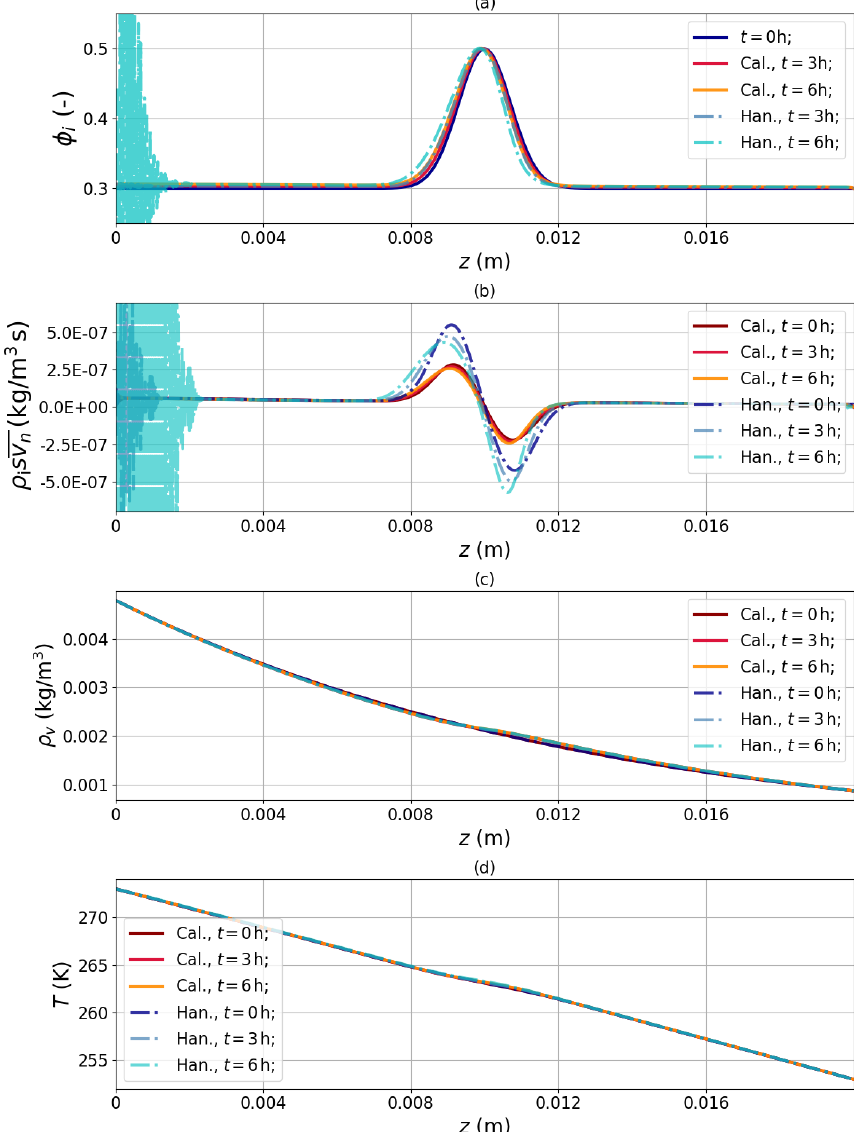
Figure 3. Comparison of Calonne’s and Hansen’s model each with their own formulation of coefficients. Both models are coupled to the evolving ice phase for an initial Gaussian profile under a temperature